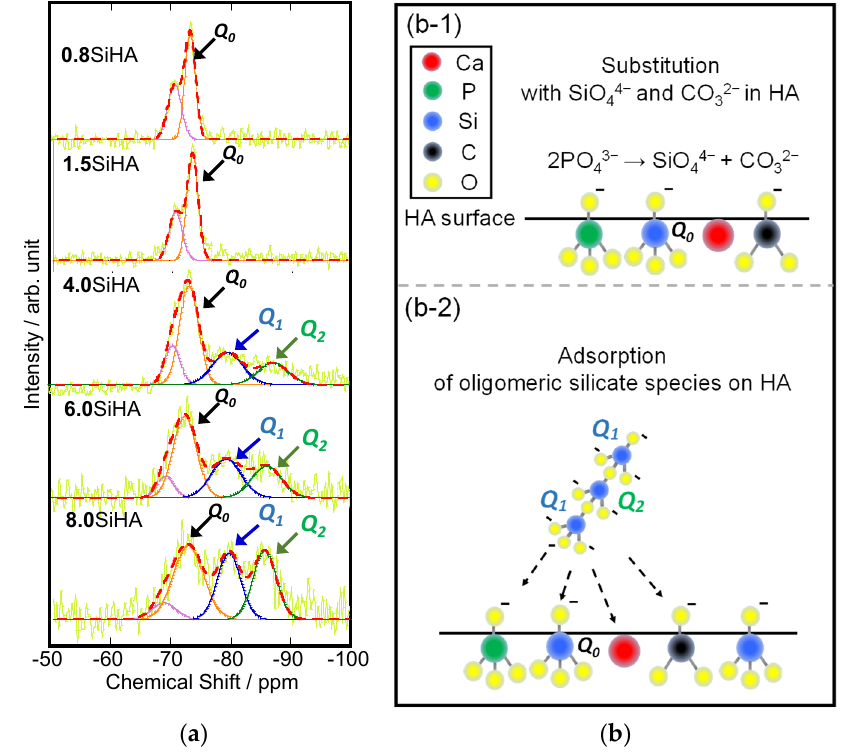
Figure 3. ( a ) Deconvolution curves (red dotted lines) and fitting results (coloured lines) of solid-state 29 Si–NMR DD-MAS spectra of the SiHA particles with the Q n ( n = 0, 1, 2) derived from raw data (yellow lines). Schemes of the possible states of carbonate and silicate ions at the HA surfaces for the case in ( b-1 ) 0.8 SiHA and 1.5 SiHA and ( b-2 ) 4.0 SiHA, 6.0 SiHA and 8.0 SiHA. The increment in the Si concentration increases the relative Q 2 peak intensity, suggesting the absorption of oligomer derived from unsubstituted silicate ions on the HA surface.